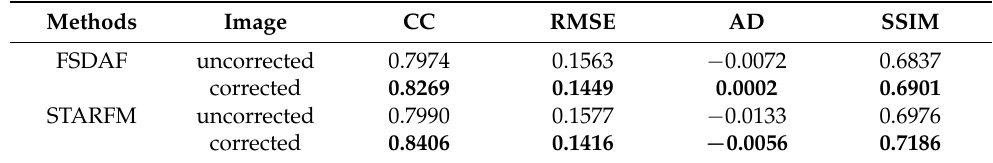
Figure 8. Scatter plots of NDVI and Landsat NDVI observations on 12 January 2002 estimated using various techniques: ( a ) FSDAF, ( b ) bias-corrected FSDAF, ( c ) STARFM, and ( d ) bias-corrected STARFM (the red line is the 1:1 line). Table 1. Accuracy of the STARFM- and FSDAF-predicted NDVIs before and after bias correction of input data for the Coleambally Irrigation Area. Best results are marked in